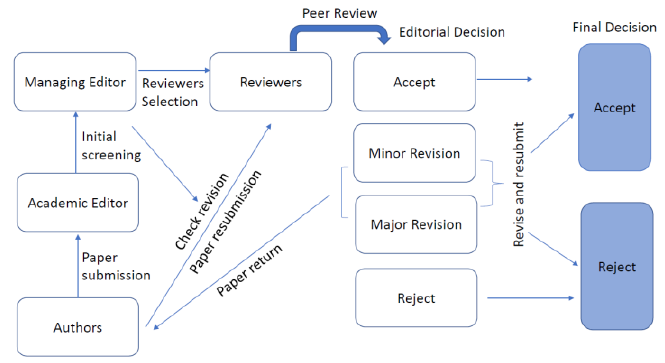
Figure 2. MDPI reviewing process.